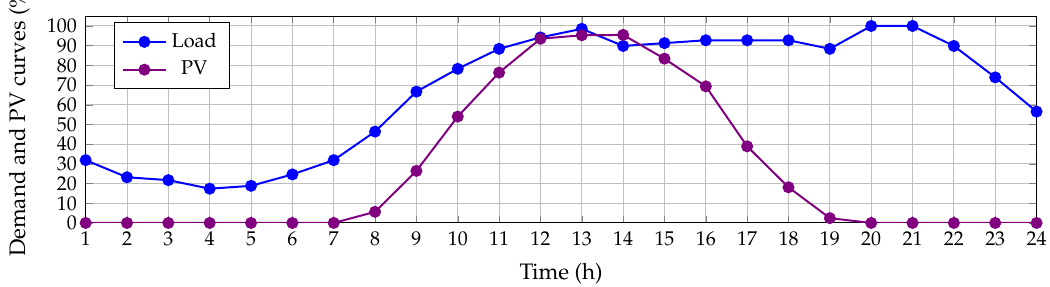
Figure 3. Typical behavior of generation and demand curves for a period of study of 24